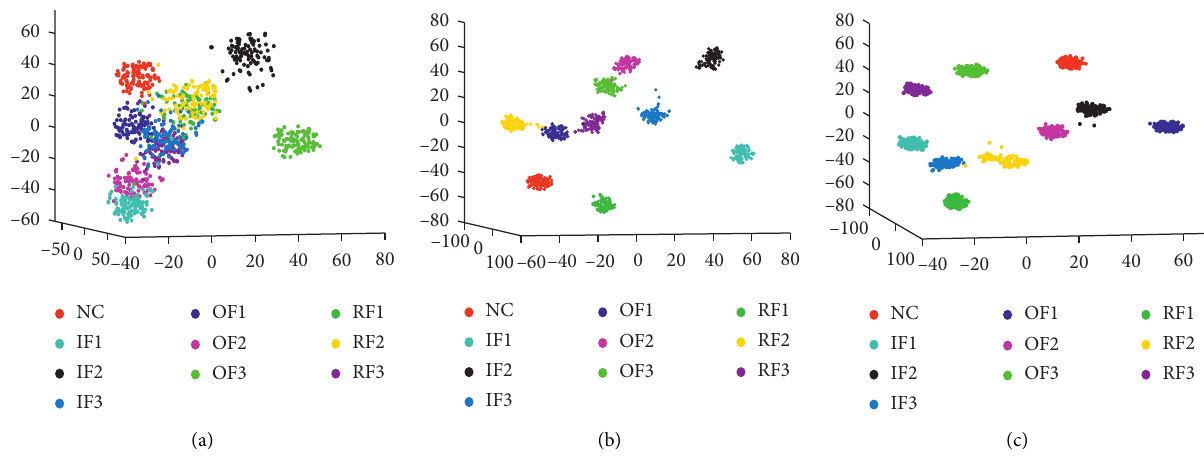
Figure 7: Comparison of dimensionality reduction visualization results on Dataset B. (a) GAN-SAE. (b) WGAN-SAE. (c)